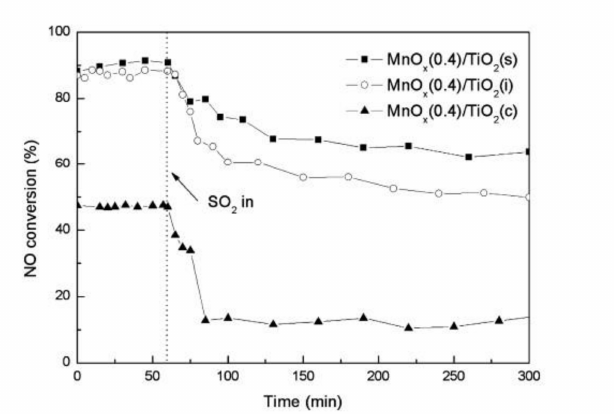
Figure 15. Sulfur resistance of Mn / TiO 2 catalyst synthesized by impregnation, coprecipitation and sol-gel method. Reaction conditions: [NO] = [NH 3 ] = 1000 ppm; [O 2 ] = 3%; N 2 balance, total flow rate = 2000 mL / min